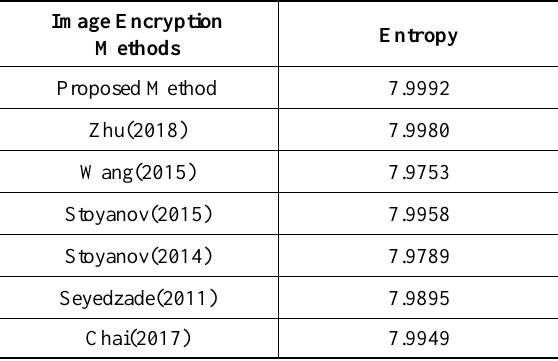
Table 1. Comparing the result of entropy test between the